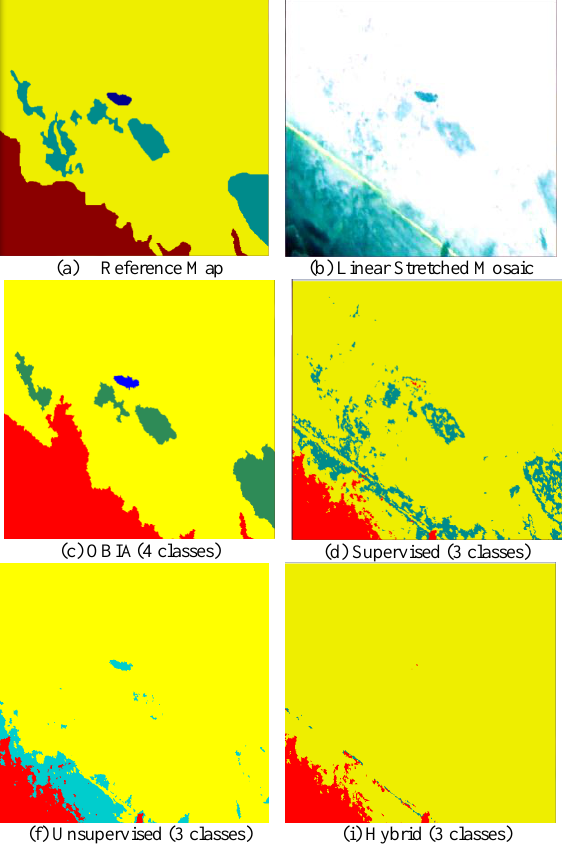
Figure 3. Classification maps of the different algorithms of a sample